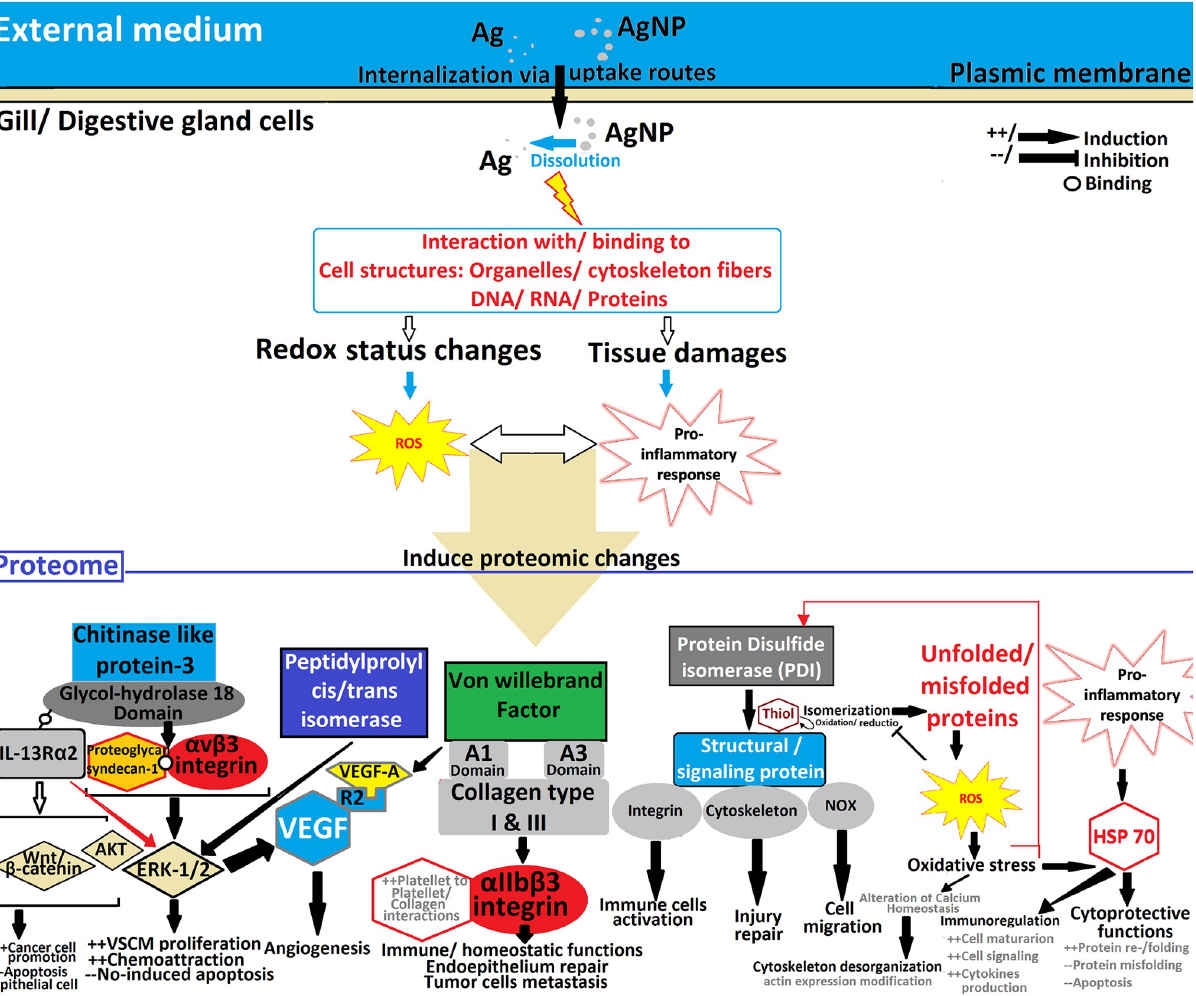
Fig 2. Schema describing the major predicted oxidative status and its related regulation mechanisms induced by AgNP through generation of ROS and inflammatory response.